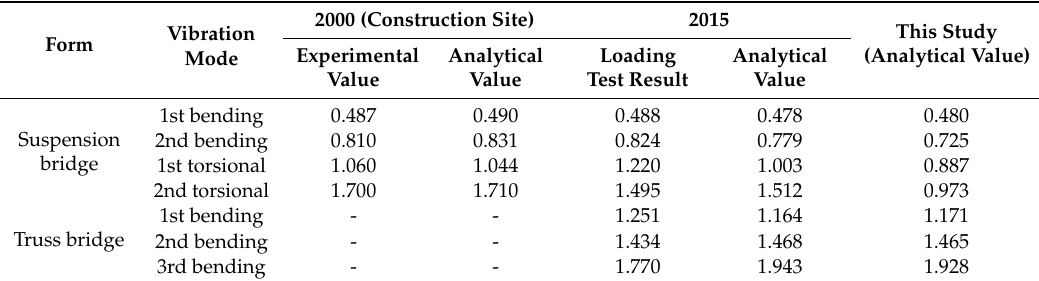
Table 1. Comparison of eigenvalue analysis results.